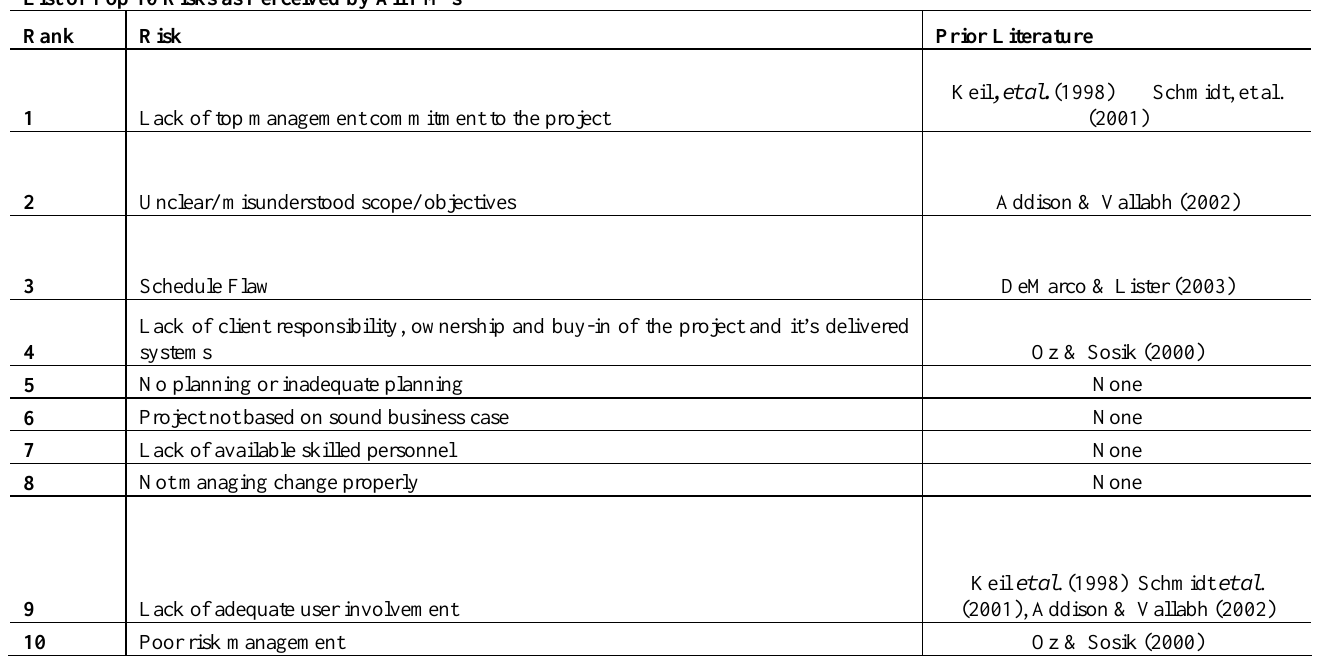
Table 4: Comparison of Top Ten Risks (all) to prior literature List of Top 10 Risks as Perceived by All PM's